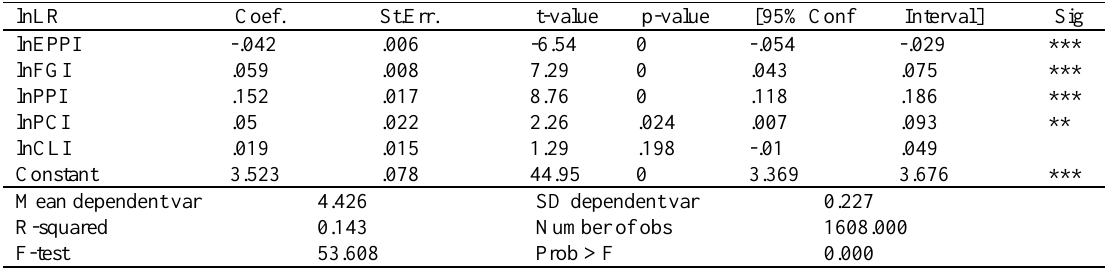
Table 5: Two stage least square (2SLS) model